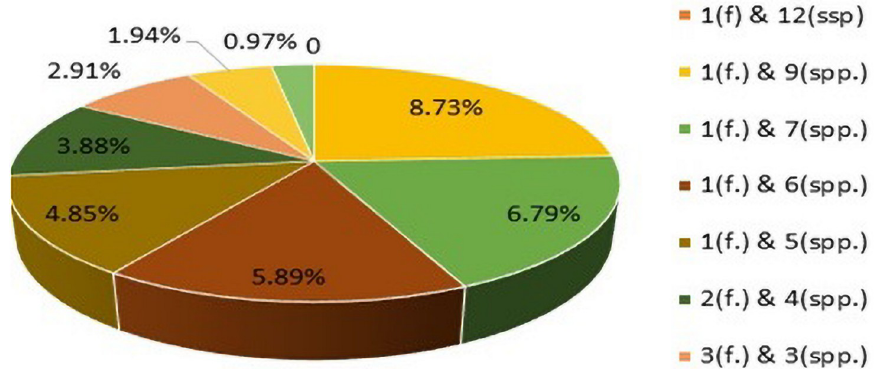
Fig 2. Species distribution pattern of each family from Dawarian and Ratti Galli area of Neelam valley of Azad Jammu and Kashmir,